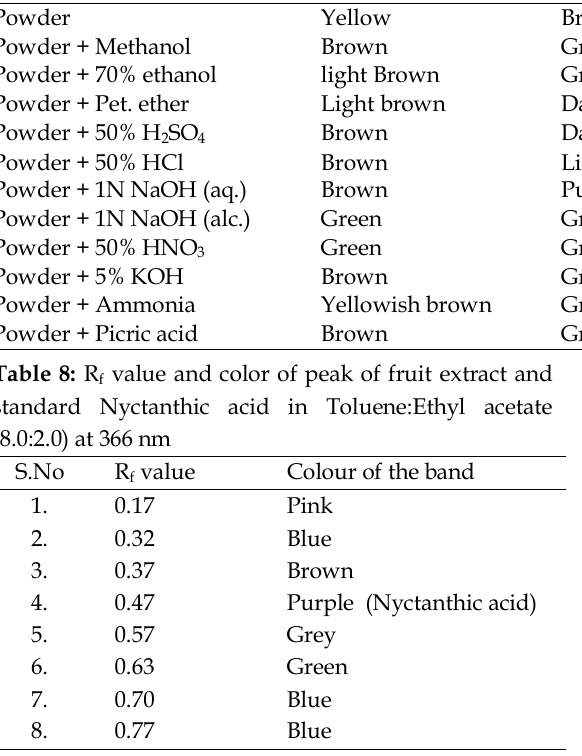
Table 7e : Fluorescence Analysis of R. indica leaf Treatment